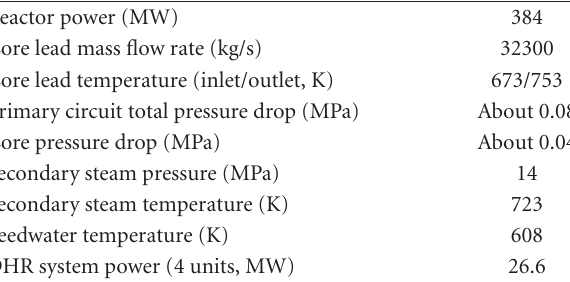
Table 1: Main EFIT thermal-hydraulic